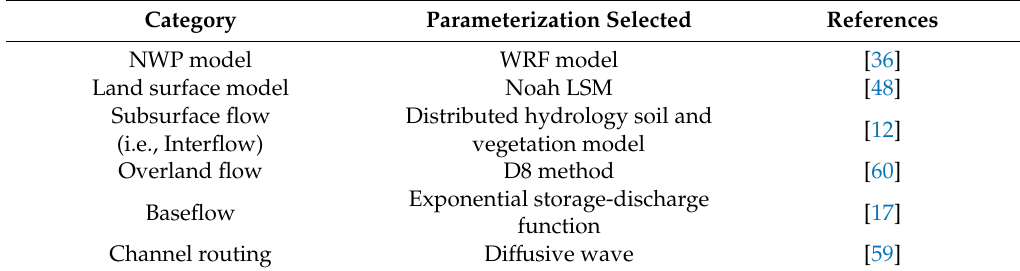
Table 3. The parameterizations of uncoupled WRF-Hydro model.